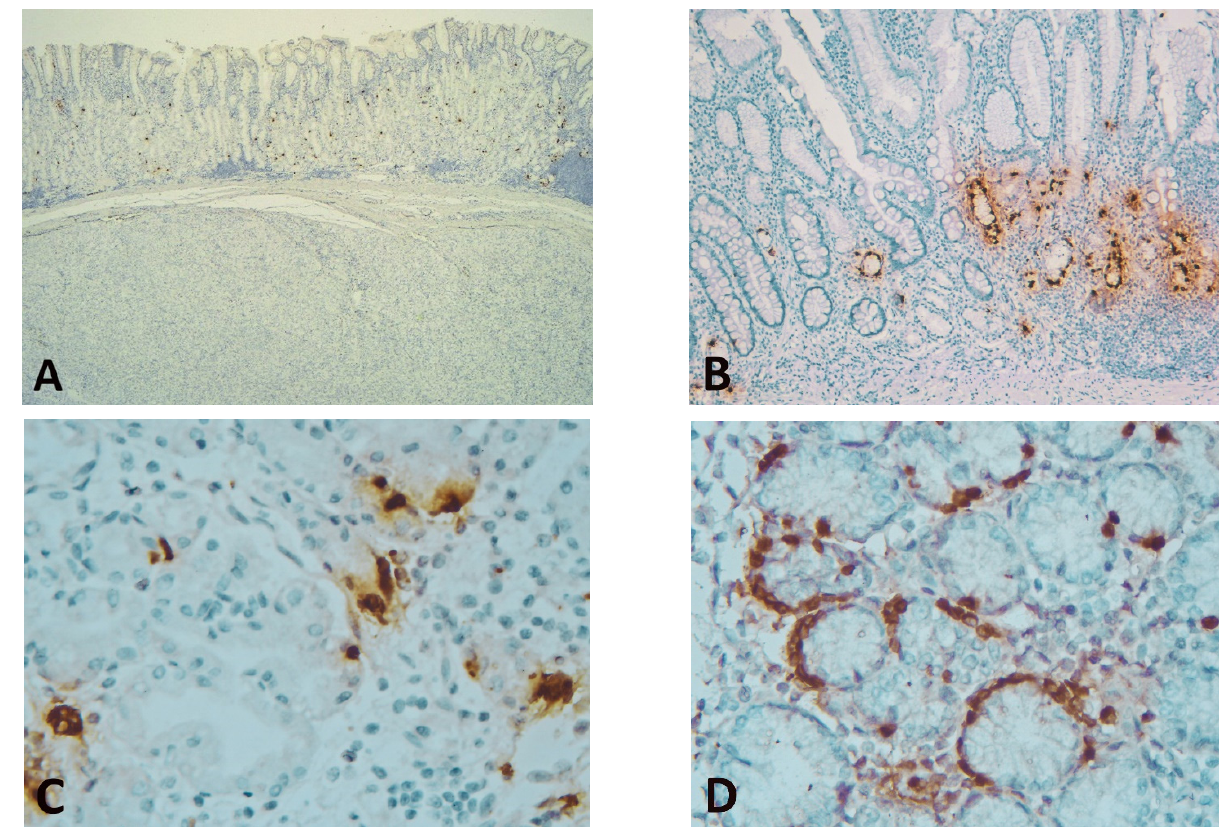
Figure 1. ( A ) Spindle cell GIST showing complete negativity for ghrelin (positive ghrelin-producing cells (GhrC) in overlying gastric oxyntic mucosa—internal control) (immunohistochemical (IHC), Anti-ghrelin antibody, × 25 magnification); ( B ) Gastric mucosa (corpus) of laparoscopic sleeve gastrectomy (LSG) patients with associated chronic gastritis and intestinal metaplasia, showing predominant lower 2/3 disposition of GhrC (IHC, Anti-ghrelin antibody, × 100 magnification); ( C ) Single cells or disposition in small groups of GhrC with intense cytoplasmic staining in the oxyntic mucosa of LSG patients; the cell count was performed at this magnification (IHC, Anti-ghrelin antibody, × 400 magnification); ( D ) Intense cytoplasmic staining of GhrC showing linear hyperplasia in isolated cases of LSG patients (IHC, Anti-ghrelin antibody, × 400 magnification).